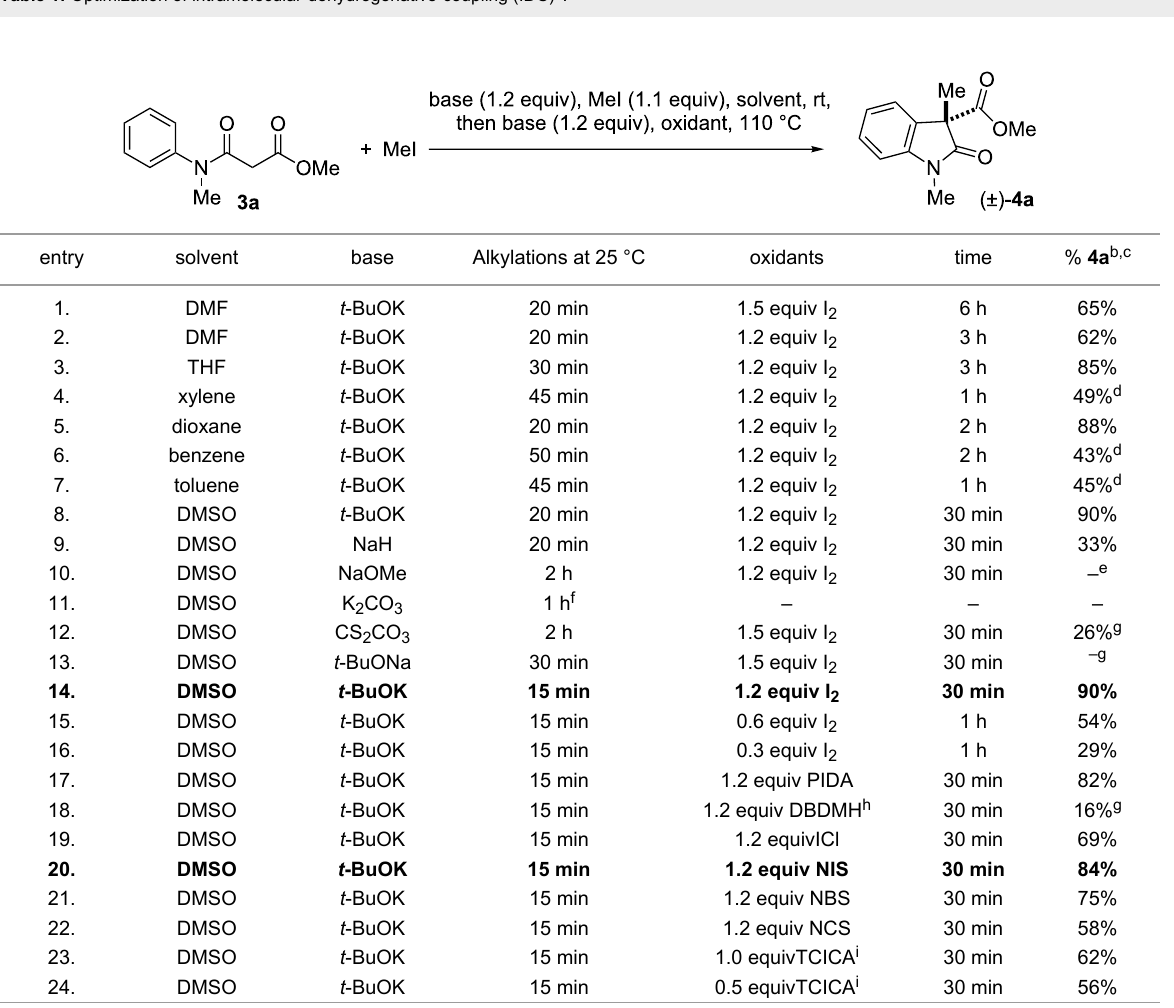
Table 1: Optimization of intramolecular-dehydrogenative-coupling (IDC) a